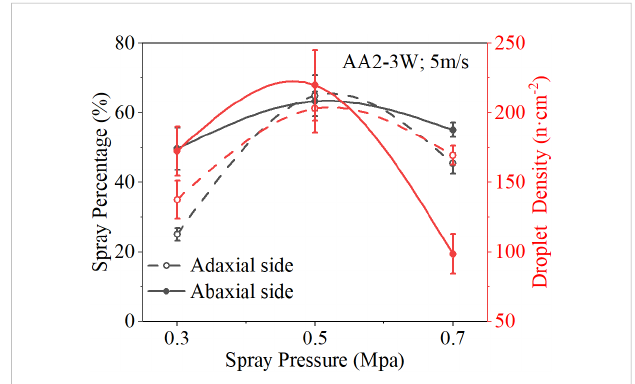
FIGURE 10 Response of Spray Deposition Distribution to Spray Pressure (AA2-3W, WS = 5